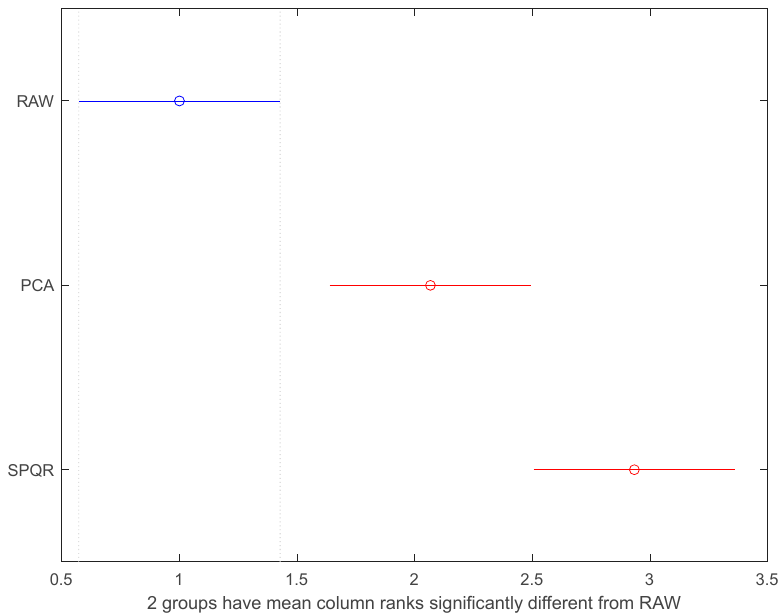
Figure 7. Results of the “multicompare” procedure.